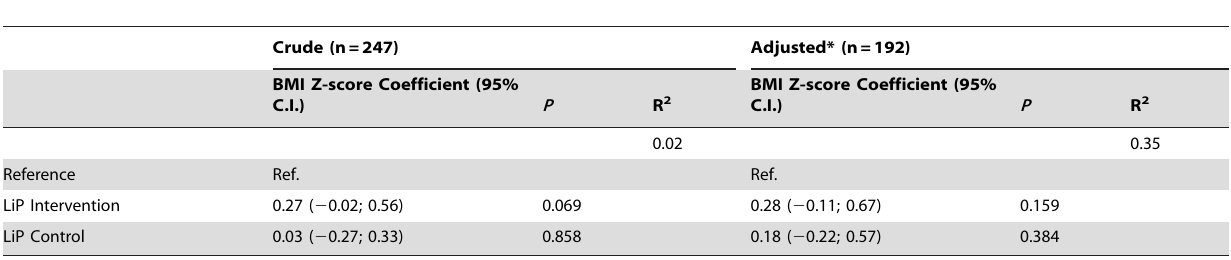
Table 3. Simple and multiple regression analyses showing crude and adjusted difference in BMI Z-score in the three groups of term children at age 2.8